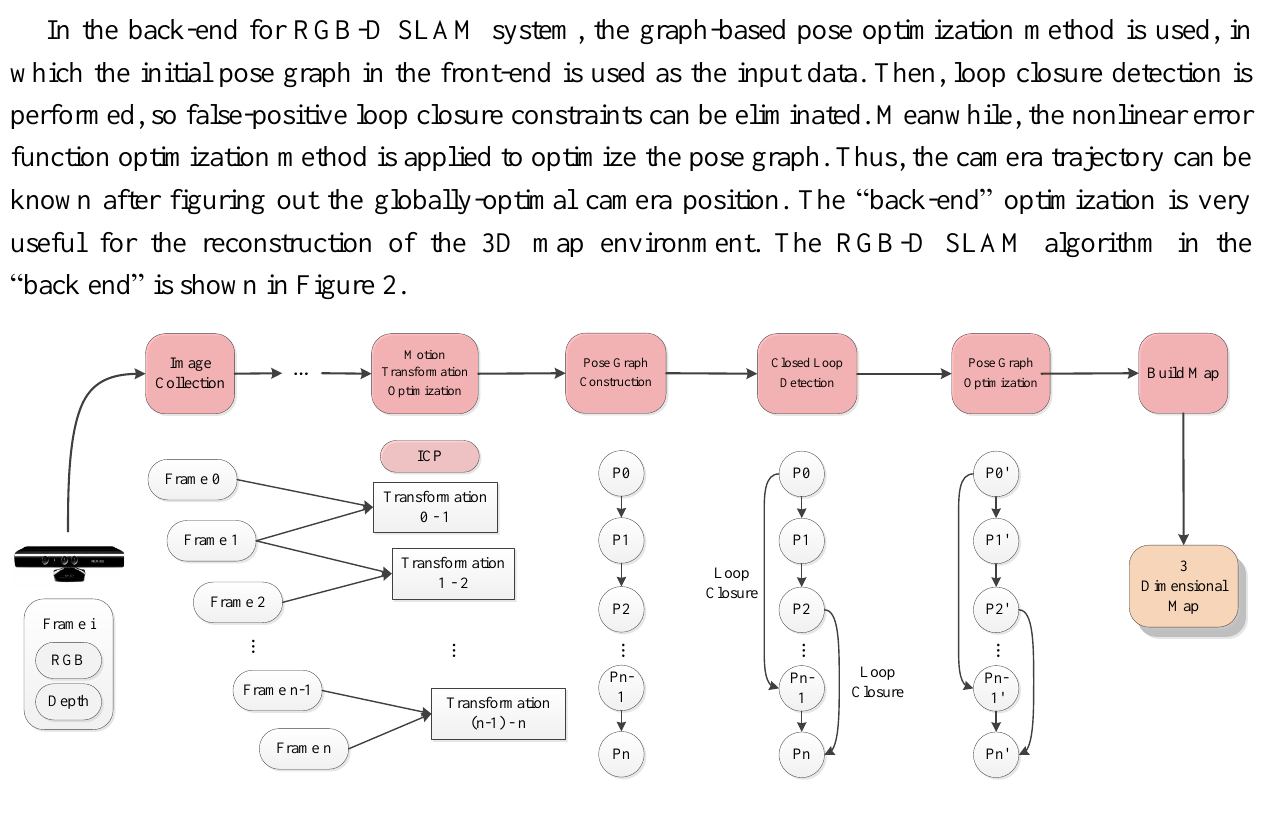
Figure 2. The sketch map for RGB-D SLAM algorithm in the back